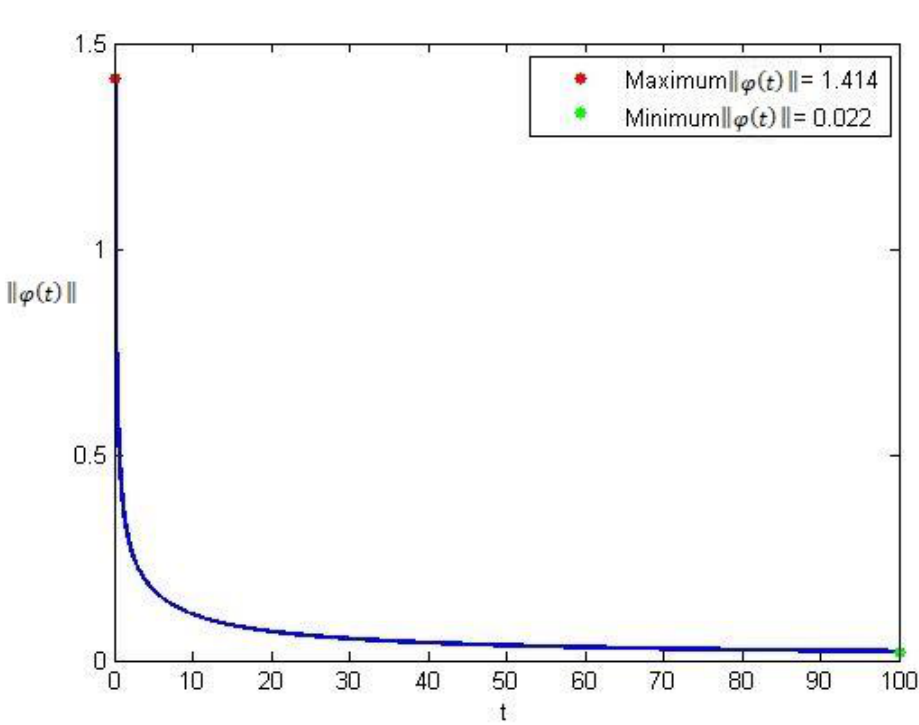
Figure 10. || ϕ ( t ) || for system (10), with α = 0.5, ρ = 1.5, and w ( t ) = Figure 10. ‖𝜑(𝑡)‖ for system (10), with 𝛼 = 0.5 , 𝜌 = 1.5, and 𝑤(𝑡) = [1 𝑒 −𝑡 ] 𝑇 .